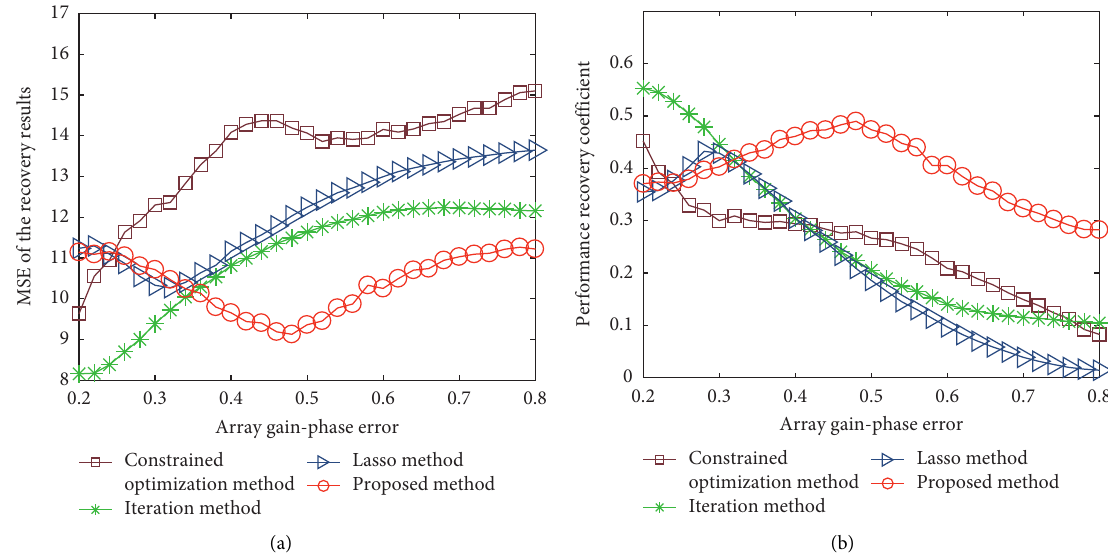
Figure 5: MSE and PRC of the sparse recovery results with the constrained optimization method [14], iterative method [15], Lasso method, and proposed method with different array gain-phase errors ( M � N � 15, SNR � 20dB, c � 15, and ρ � 0 . 2). (a) MSE of the sparse recovery results with different array gain-phase errors. (b) PRC of the sparse recovery results with different array gain-phase errors.